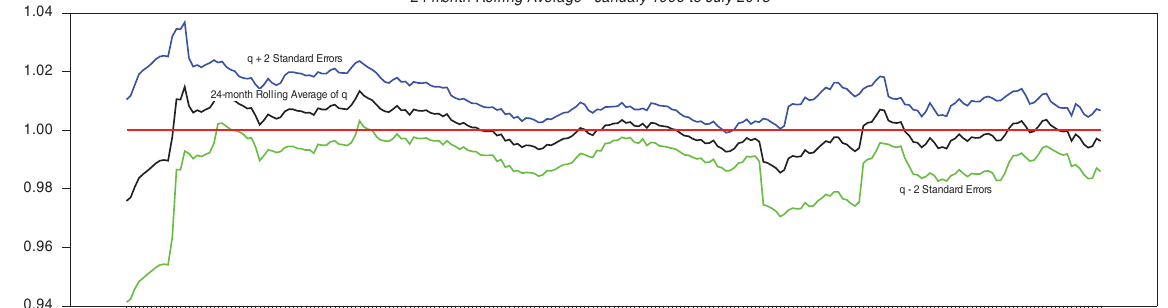
Fig. 13. Mexican peso-Chinese yuan real exchange rate